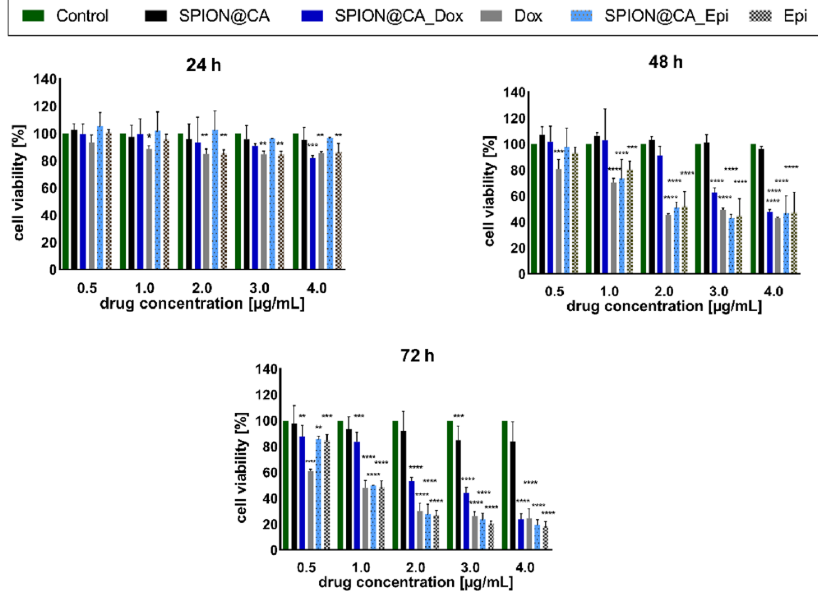
Figure 10. Cell viability of SKOV-3 cells treated with SPION@CA, SPION@CA_Dox, Dox, SPION@CA_Epi, and Epi after 24 h, 48 h, and 72 h. Nontreated cells were used as a control. Data are expressed as ± SD ( n = 3). Statistical significance was considered if p < 0.05 (*), p < 0.01 (**), p < 0.001 (***) and p < 0.0001 (****).